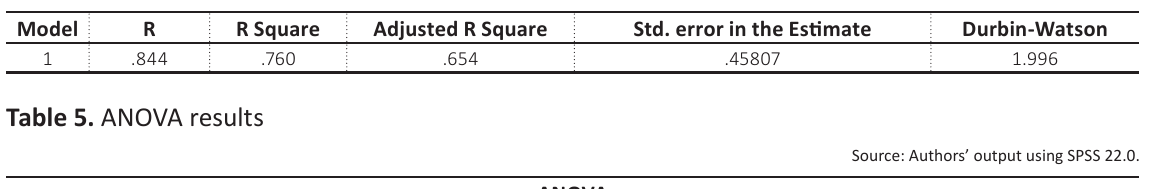
Table 4. Model summary